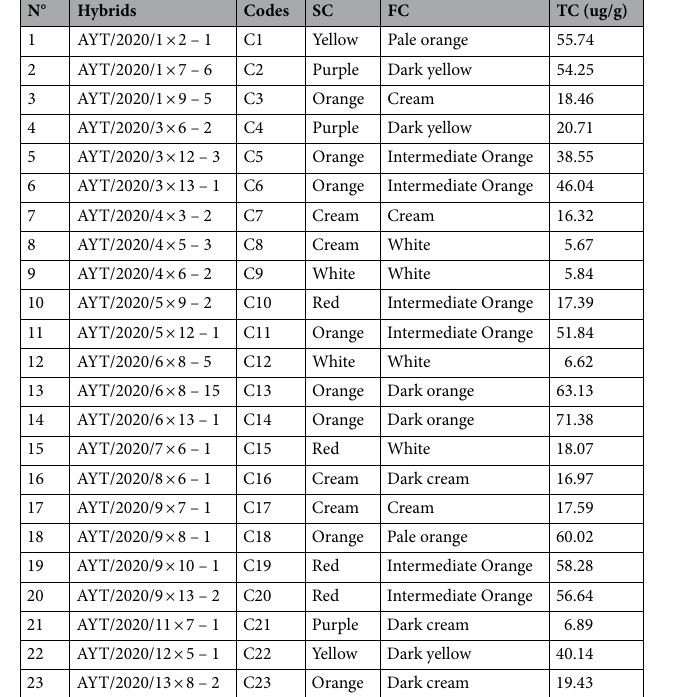
Table 1. Description of 23 progenies used in AYT. AYT advanced yield trial, C clone, SC skin colour, FC flesh colour, TC total carotene.